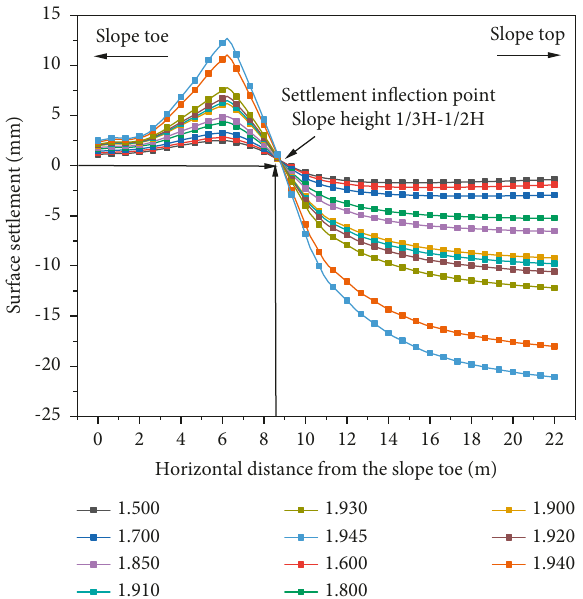
Figure 12: Distribution law of tunnel surface settlement.